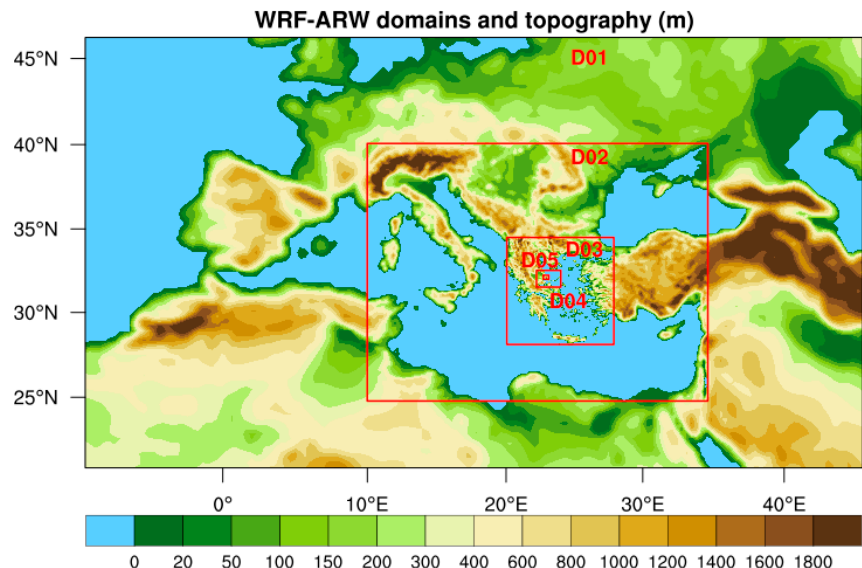
Figure 3. WRF-ARW version 4.0 weather model domains and topography (m). The nested domains are depicted with red polygons.